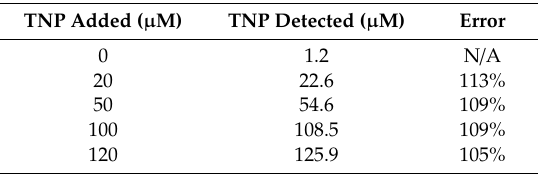
Figure 11. RS6h@EuBTC exposed to daylight condition under no TNP ( left ) and TNP concentration of 20 μ M ( right ). Table 2. Ratiometric fluorescent sensing result ofRS6h@EuBTC.